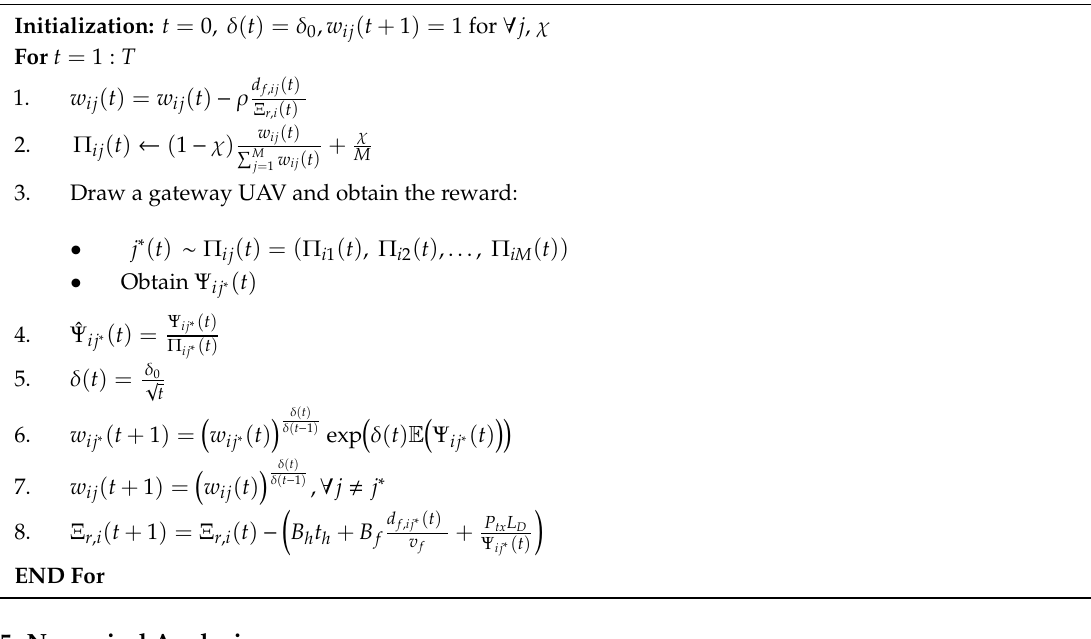
Algorithm 3: BA-EXP3 gateway UAV